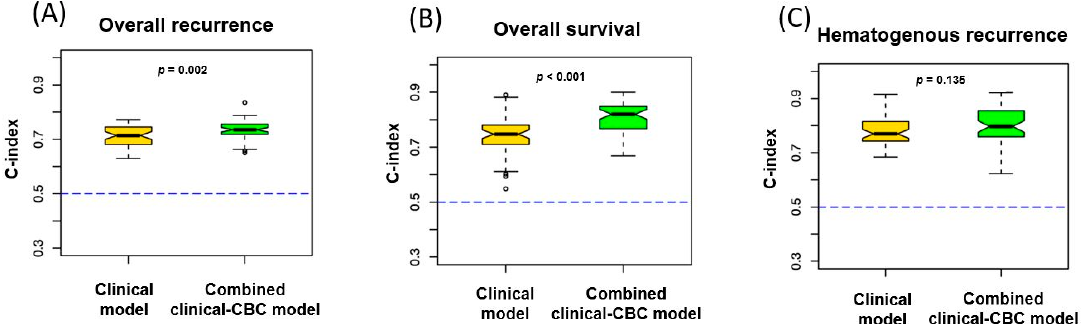
Figure 3. ( A ) The concordance index (C-index) of overall recurrence, ( B ) overall survival, and ( C ) hematogenous recurrence calculated each by the known prognostic factors only and the known prognostic factors with CBC profiles added. The yellow boxes-and-whiskers represent the C-index calculated by the known prognostic factors only and the green boxes-and-whiskers represent the C-index calculated by the known prognostic factors with CBC profiles added. The blue dotted lines represent the C-index value of 0.5, scores under which indicate that the model is no better than chance results. Cross validation based on bootstrap resamplinggenerated ranges of C-index represented in each figure.